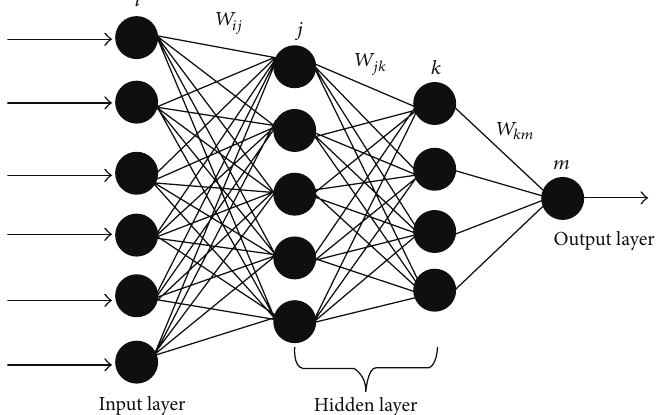
Figure 2: A typical four-layer feedforward